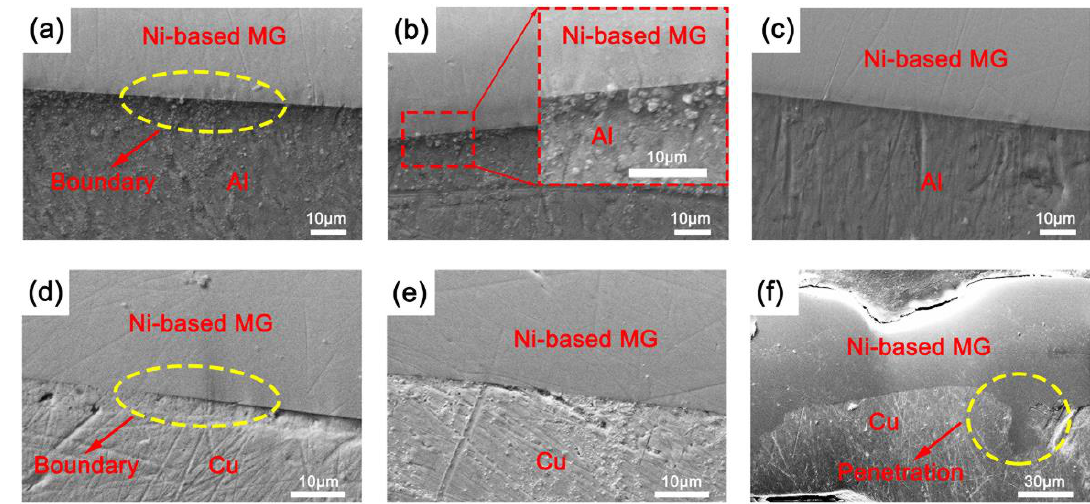
Figure 3. Cross-sectional morphologies of Al / Ni-based (MG) composite samples ( a – c ) at bonding times of 60, 80, and 160 ms, as well as cross-sectional morphologies of Cu / Ni-based (MG) composite samples ( d – f ) at bonding times of 40, 60, and 140 ms.